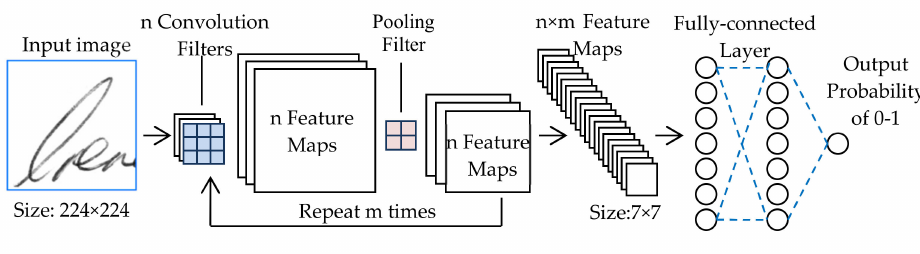
Figure 1. Schematic diagram of CNN, using the Vgg19 architecture for example